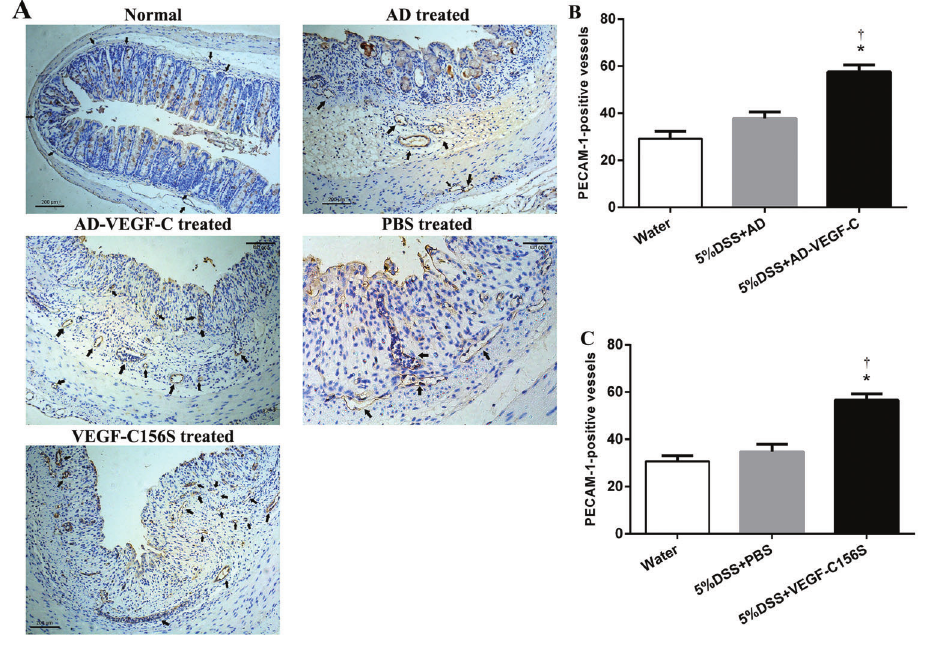
Figure 4. Immunohistochemical results for blood vessel remodeling in acute colitis ( A ). Comparison of microvessel density between AD-VEGF-C treated and DSS-treated mice ( B ) and between AD-VEGF-C156S-treated and PBS-treated mice ( C ). Both AD-VEGF-C and VEGF-C156S induced a signi fi cant increase in microvessel density compared to DSS-treated mice (both P o 0.001). Data are reported as means ± SD (n=5/per group). *P o 0.05 compared to DSS- or PBS-treated mice. w P o 0.05 compared to water-treated mice. Statistical analysis was performed by ANOVA and Bonferroni ’ s post hoc test. AD-VEGF-C: adenovirus vascular endothelial growth factor-C; DSS: dextran sodium sulfate. PECAM 1: polyclonal